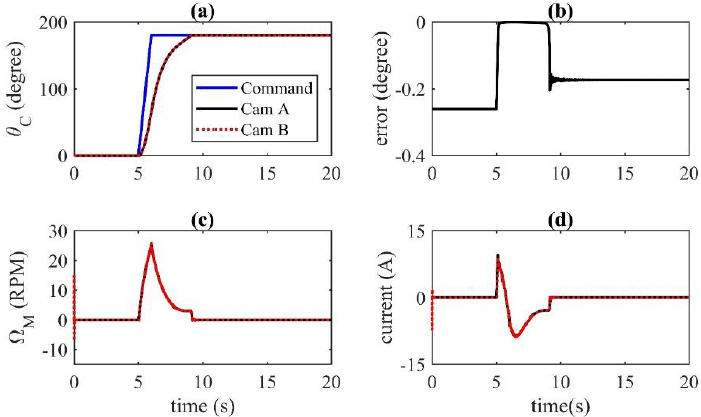
Figure 11. Comparison of performances for both the cams within the actuator: ( a ) angular position of the cams; ( b ) error in the angular position between the cams; ( c ) motor angular velocities; ( d ) motor input currents.